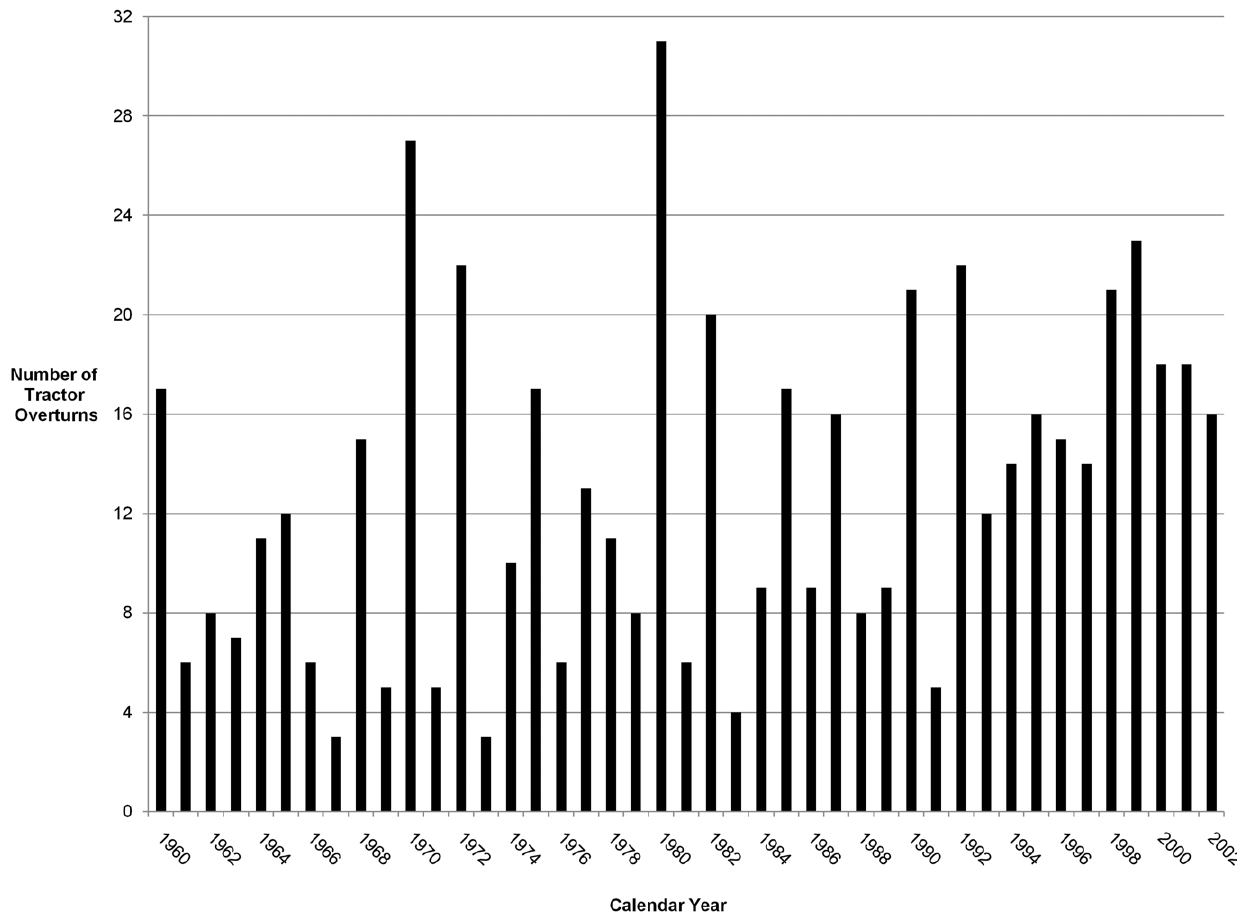
Figure 1. Tractor overturns by year in Kentucky, 1960–2002. Source: Kentucky Tractor Overturn Survey (KY T/O) (15).